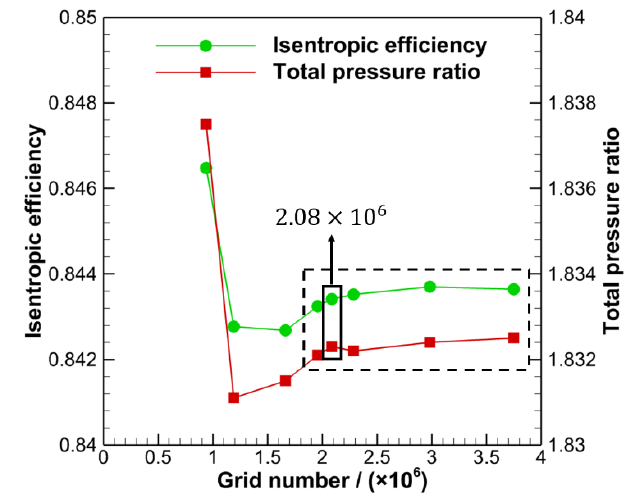
Figure 2. Compressor performance vs. grid number.